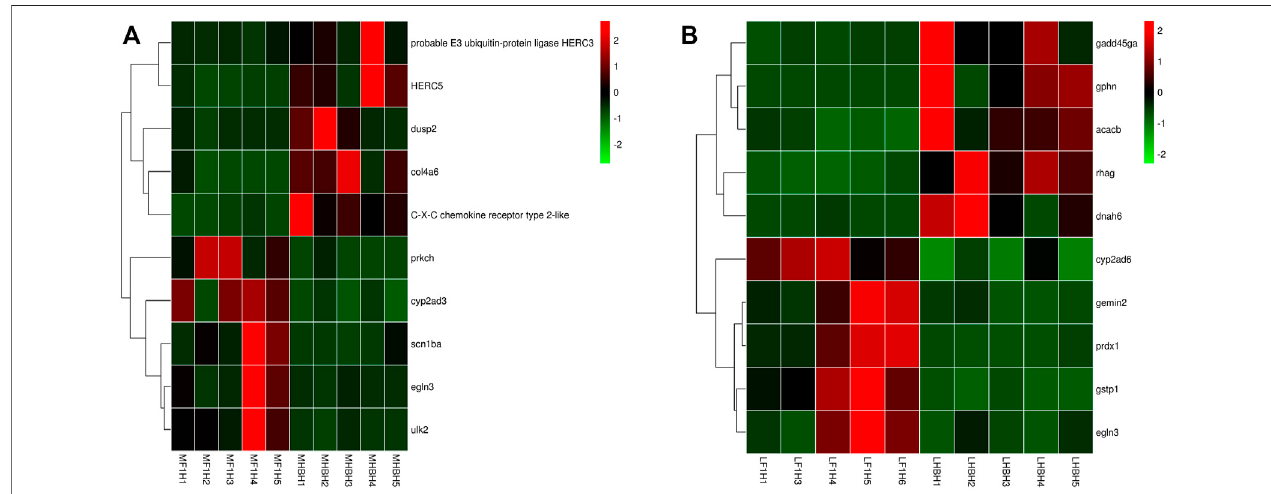
FIGURE 6 | Hierarchical clustering of HSDEGs between hybrid F1carp and Hebao red carp based on the average correlation of the log2 expression values. (A) HSDEGs in the HF group muscle (MF1N1, MF1N2, MF1N3, MF1N4, MF1N5, MF1H1, MF1H2, MF1H3, MF1H4, MF1H5). (B) HSDEGs in the HF group liver (LF1N1, LF1N2, LF1N3, LF1N4, LF1N5, LF1H1, LF1H3, LF1H4, LF1H5,